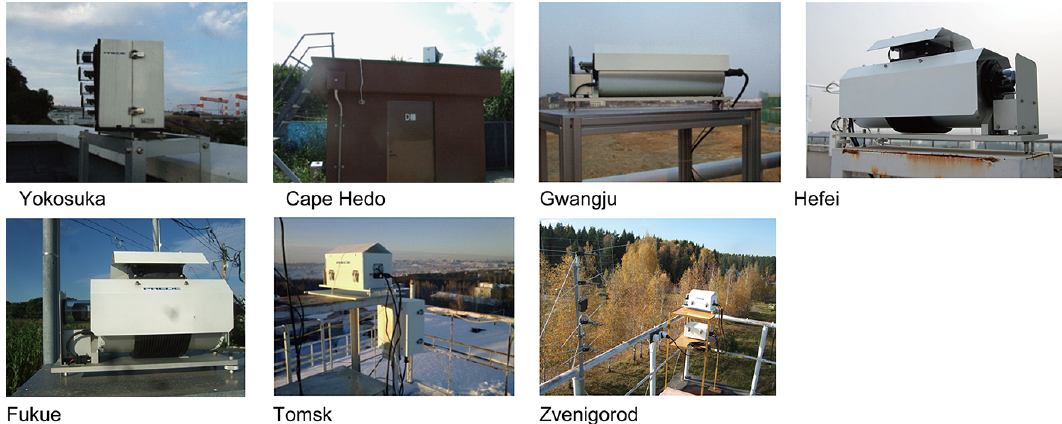
Figure 4. Light-receiving parts of MAX-DOAS instruments located at the seven